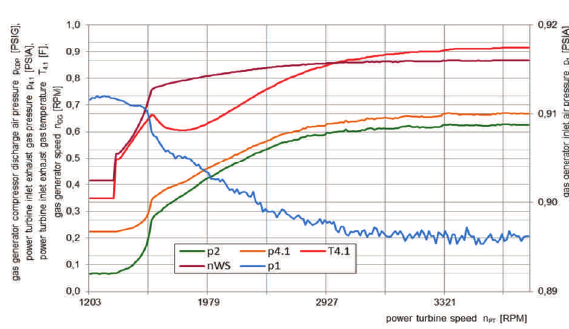
Fig. 16. Changes of LM 2500 engine operating parameters depending on the power turbine speed n PT during acceleration